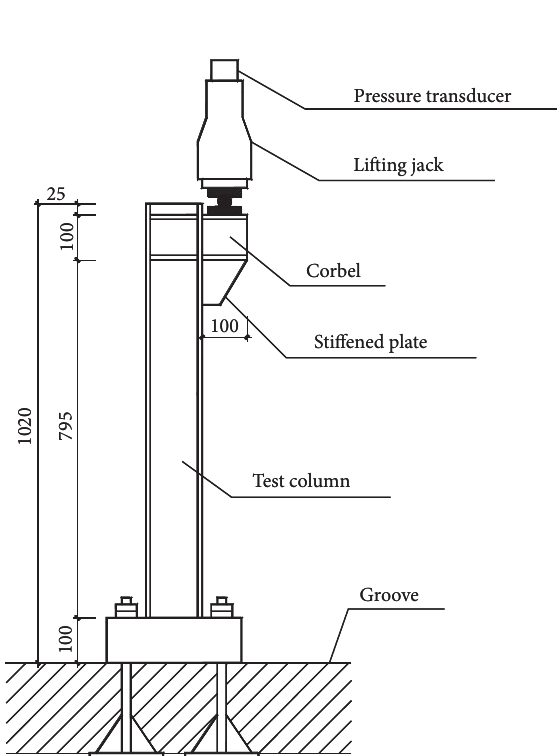
Figure 14: Schematic diagram of the loading setup.